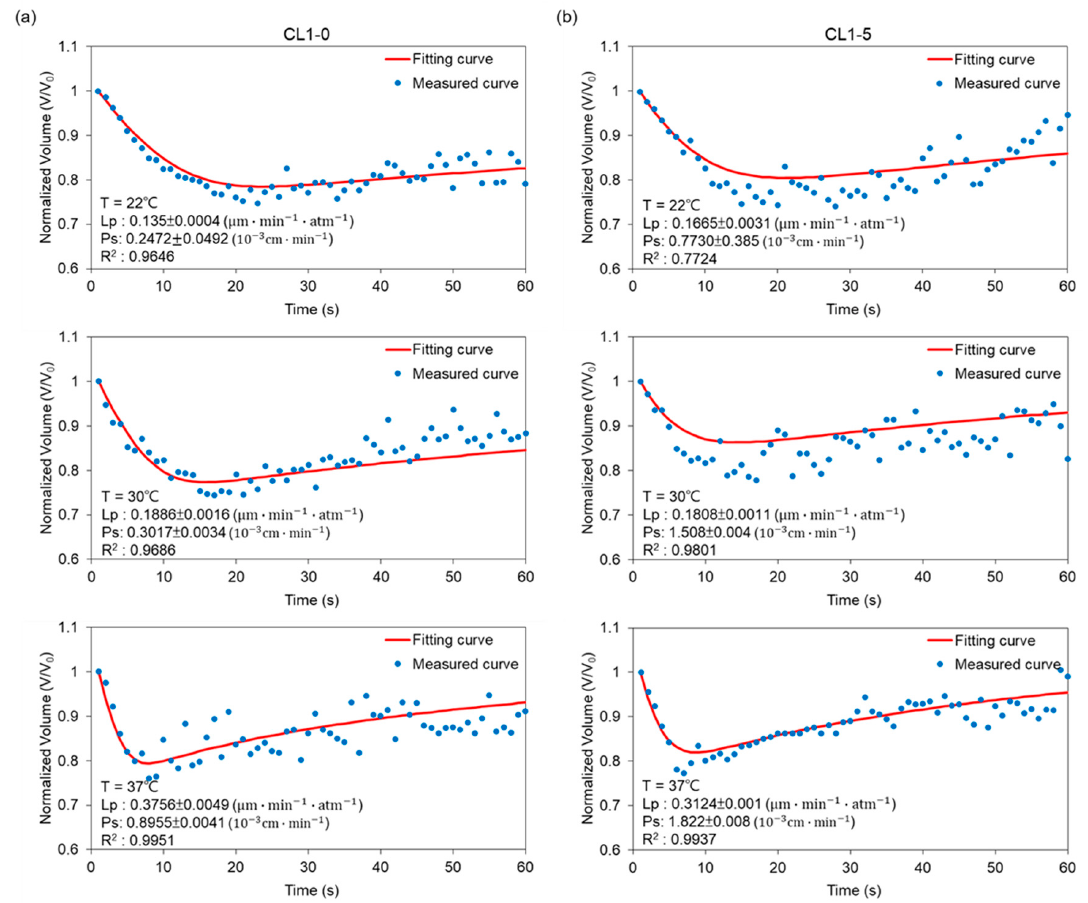
Figure 5. Volumetric changes of ( a ) CL1-0 and ( b ) CL1-5 suspended in a solution containing 10% DMSO and 0.9% NaCl ( a – c ) at 22, 30, and 37 °C, respectively. The predicted curve was calculated DMSO and 0.9% NaCl ( a , b ) at 22, 30, and 37 ◦ C, respectively. The predicted curve was calculated according to Equations (6) and (7). according to Equations (6) and